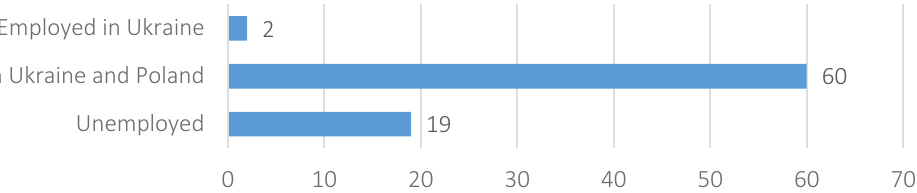
Figure 3. Distribution of scholars by science fields